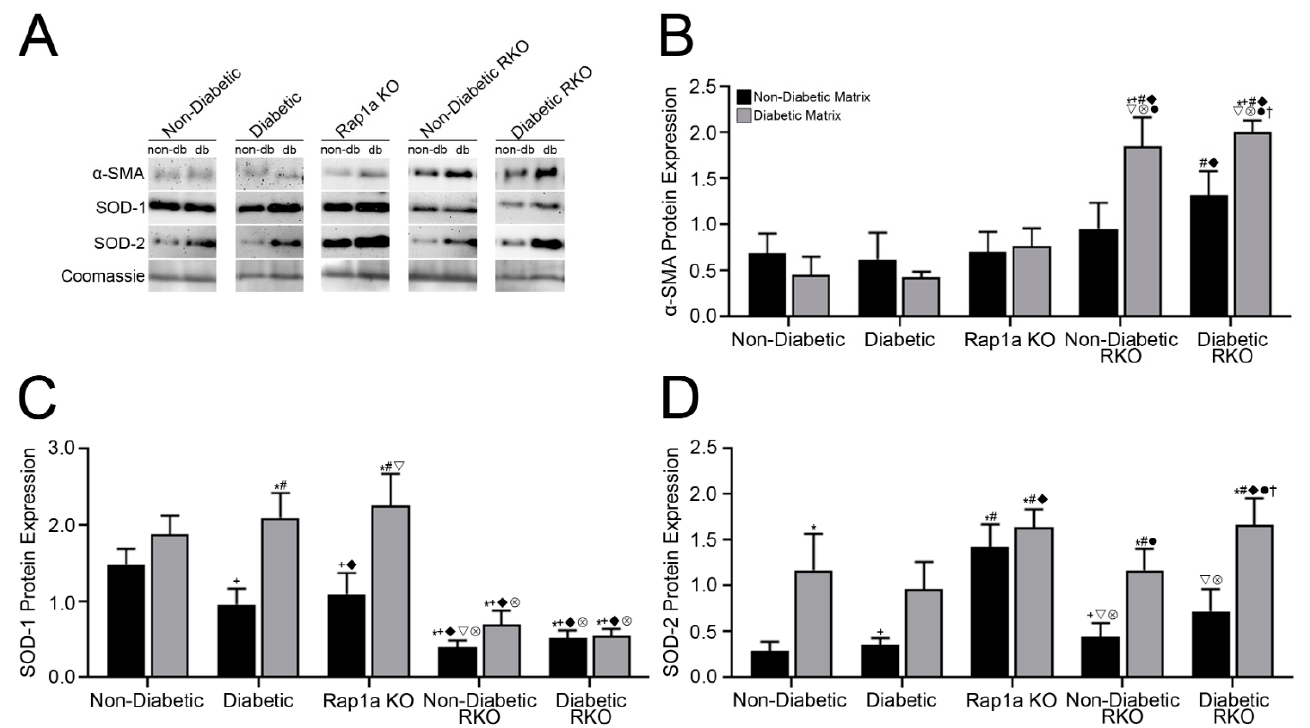
Figure 3. Isolated ECM and genotypic variation induced significant changes in expression of proteins associated with RAGE signaling. Cardiac fibroblasts isolated from non-diabetic, diabetic, Rap1a KO, non-diabetic RKO, and diabetic RKO were embedded in either non-diabetic (black bar) or diabetic (grey) collagen and cultured for 7 days. ( A – D ) Isolated protein was used for Western blot analysis to determine changes in protein expression. Western blot analysis for ( B ) α -SMA (42 kDa), ( C ) SOD-1 (23 kDa), and ( D ) SOD-2 (25 kDa) was normalized to total protein (Brilliant Blue Coomassie Stain), and graphs depict mean ± SEM ( n = 5–10). Representative Western blot images shown in A are not displayed as a continuous blot due to limitations regarding number of samples and running lanes, but samples of the same genotype were run on the same blot. Statistical analysis consisted of a two-way ANOVA followed by a Fisher’s Least Significant Difference post hoc. Symbols above each bar indicate significance between a specific group ( p < 0.05; * vs. non-db cells in non-db, + non-db cells in db, # db cells in non-db, (cid:117) vs. db cells in db, (cid:53) vs. Rap1a KO cells in non-db, ⊗ Rap1a KO cells in db, • non-db RKO cells in non-db, and † vs. db RKO in non-db).